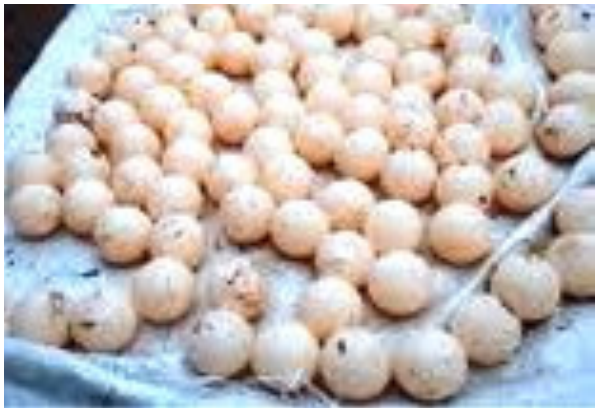
Fig. 2. Map showing the location (arrow mark) of nesting pit at Pamban coast